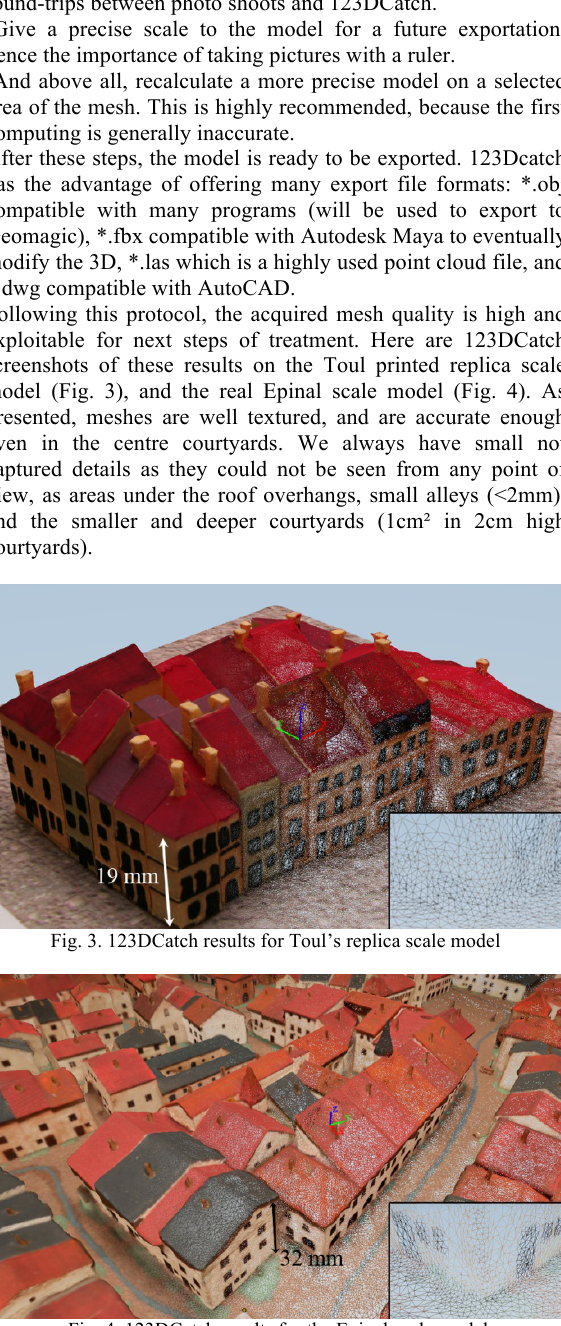
Fig. 4. 123DCatch results for the Epinal scale